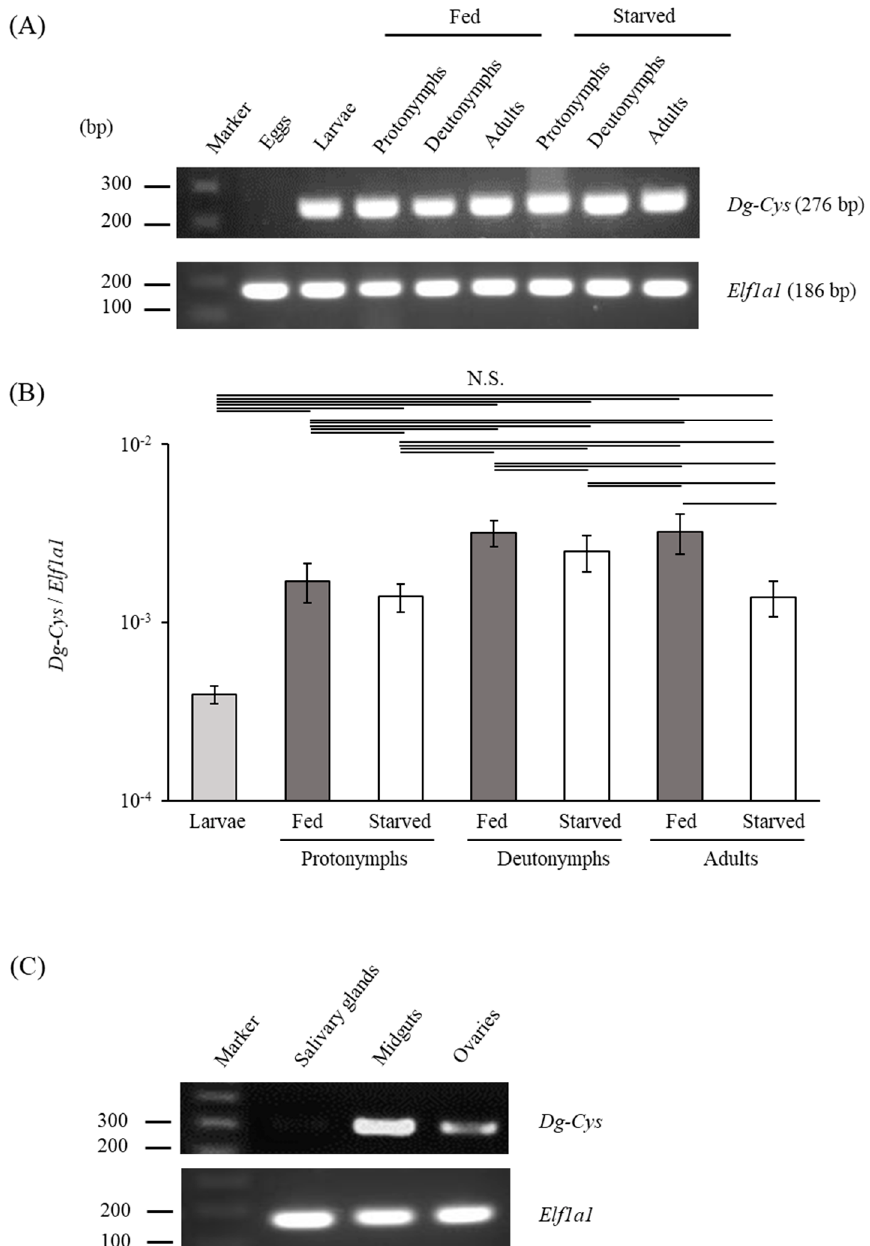
Figure 2. Gene expression analysis of Dg-Cys . Dg-Cys expression was examined by RT-PCR/nested PCR at each life-stage and blood-feeding state ( A ), and in different tissues of PRMs ( C ). Elongation factor 1-alpha 1 -like gene ( Ef1a1 ) was amplified as an internal control. ( B ) Real-time quantitative RT-PCR was performed to quantify the gene expression of Dg-Cys at each life-stage and blood-feeding state of PRMs. The extent of Dg-Cys expression was calculated by dividing the copy numbers of Dg-Cys by those of Elf1a1 . Each experiment was repeated four times and error bars indicate SEM. Statistical analyses were performed using Steel–Dwass test. N.S.: not significant. ( C ) The expression of Dg-Cys in the midguts and ovaries was analyzed by RT-PCR, and the expression in the salivary glands was analyzed by RT-nested